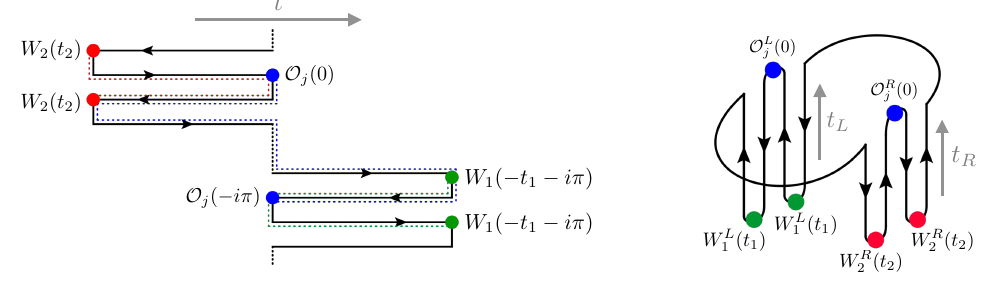
Figure 5 . Six-point configuration F 6 corresponding to the case a = b = 0 (‘maximally’, but not ‘irreducibly’ out-of-time-order). We show both the contour-time picture, and the left-right